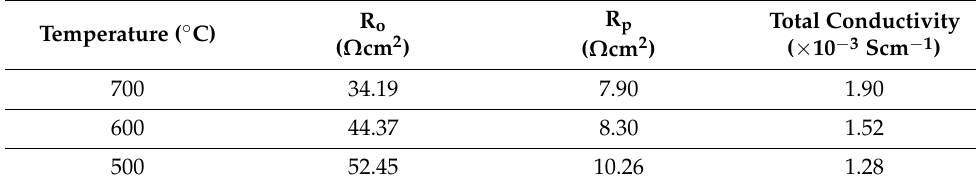
Table 4. The area specific resistance and total conductivities of single cell at 500–700 ◦ C.